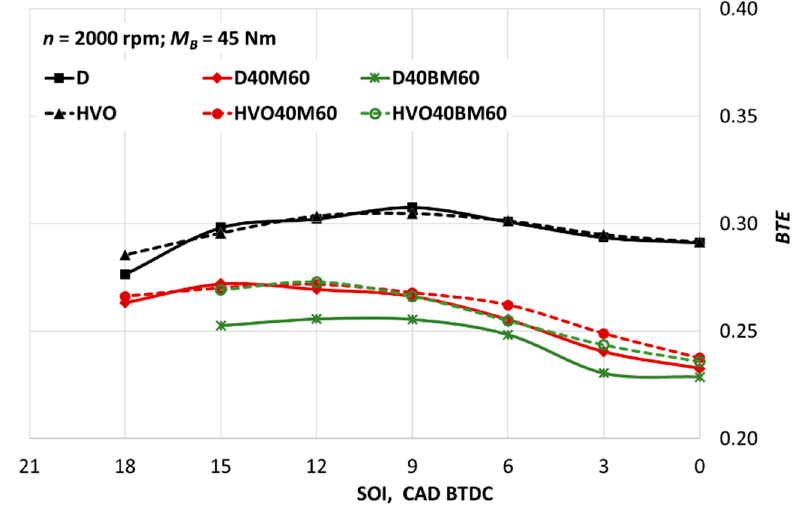
Figure 4. Change of the Brake Thermal Efficiency depending on fuel composition and SOI.